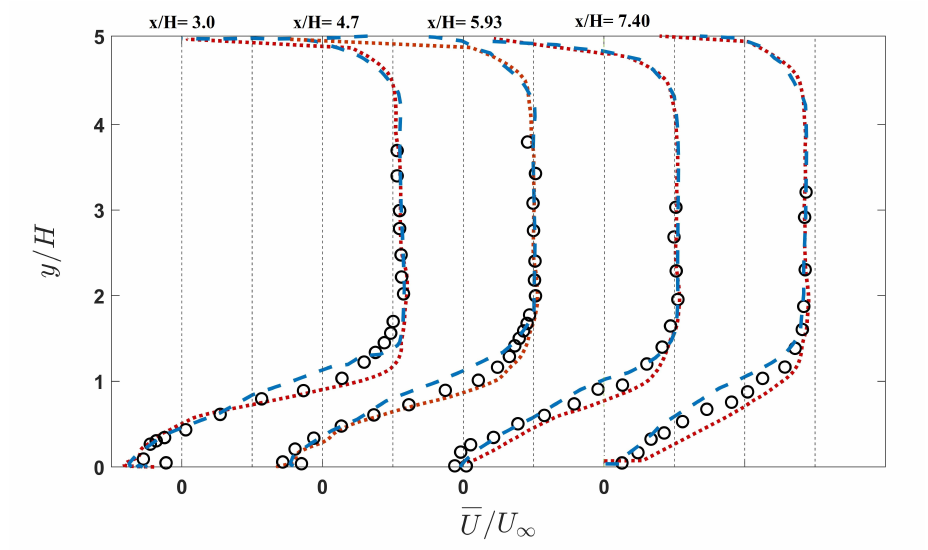
Figure 4. Mean axial velocity profiles in various streamwise locations. IDDES (red dotted line), LES (blue dashed line), and corresponding experiment (circles).